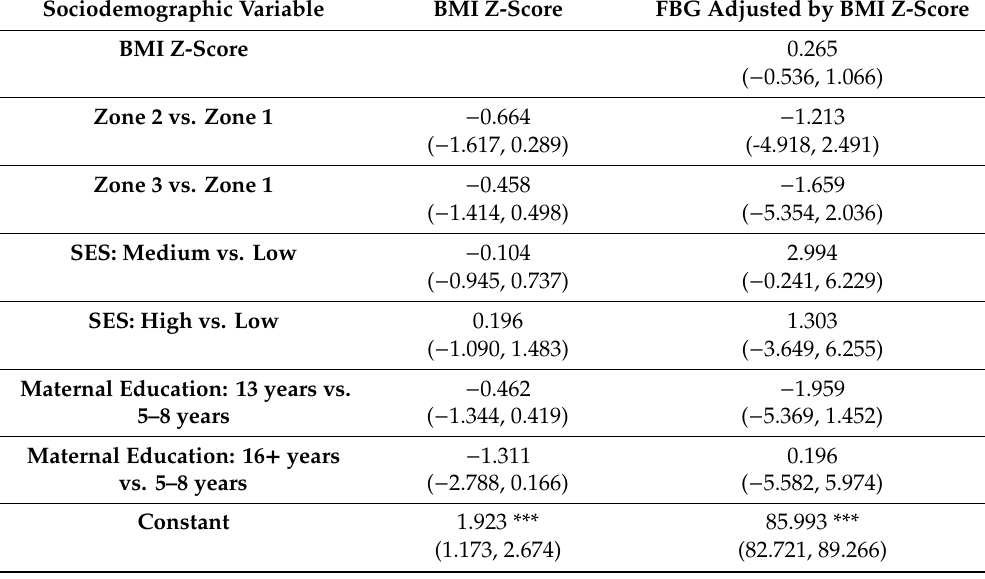
Table 5. Male participants ( n = 100): Linear regression coe ffi cients and 95% confidence intervals for associations of (i) residential zone; (ii) socio-economic status (SES) index; and (iii) maternal education level to body mass index (BMI) Z-score and BMI-adjusted fasting blood glucose